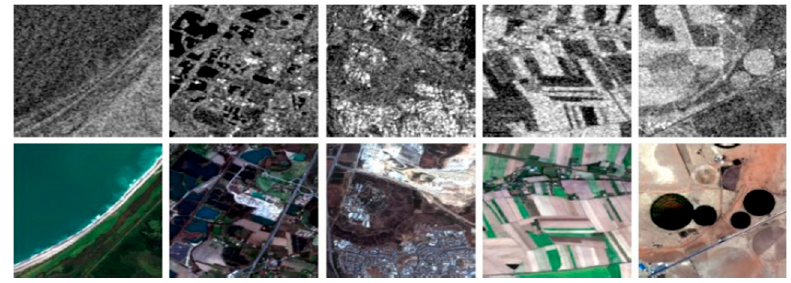
Figure 9. A sample diagram of the SEN1-2 dataset.